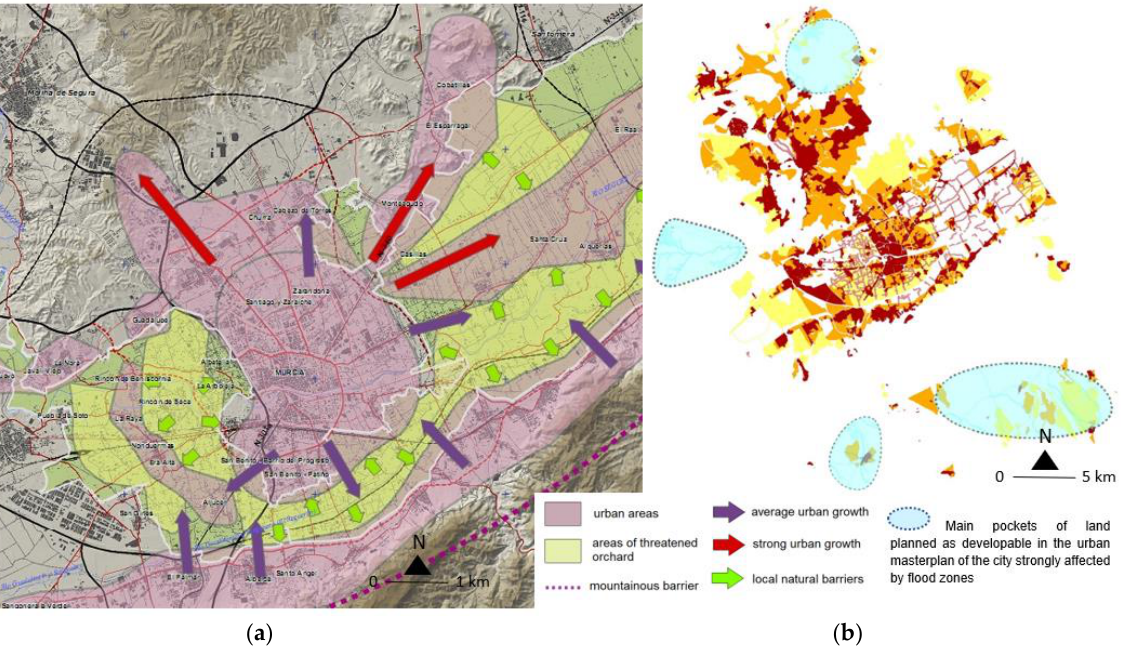
Figure 11. Graphical scheme representation of trend analysis of growth patterns in the city of Murcia: ( a ) spatial distribution of the main vectors of growth and transformation of the peri-urban space vs. the resistance inertia of the orchard; ( b ) Levels of the demographic intensity of the urban areas of the city and main “pockets” of urban development foreseen in the planning in flood-prone